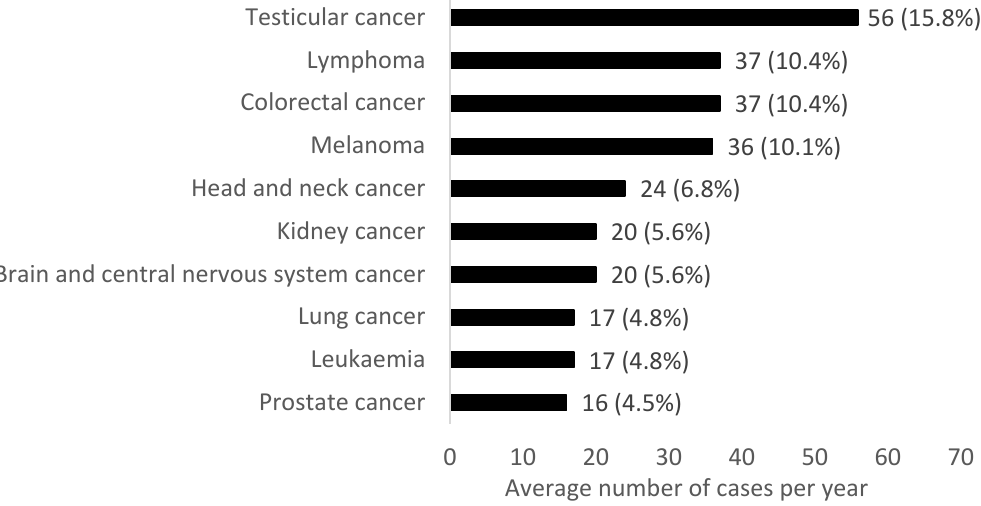
Figure 2. Average number of cases per year for the most common cancers (excluding non-melanoma skin cancer) in males aged 18 – 49 years in Northern Ireland from 2010 – 2019. Percentages refer to the proportion of the total average number of cancer cases per year.